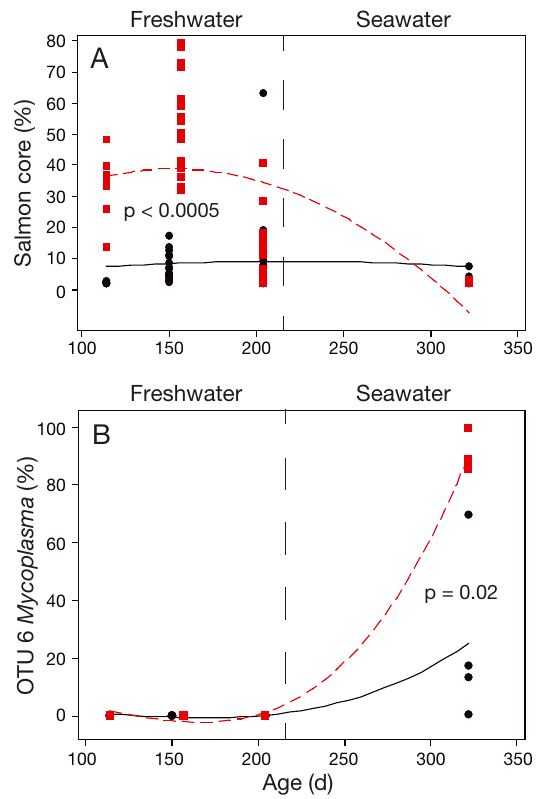
Fig. 4. Age-related development of (A) core microbiota and (B) Mycoplasma for high long-chain polyunsaturated fatty acids (LC-PUFA) (black circle) and low LC-PUFA (red square) freshwater conditions. Significance determined